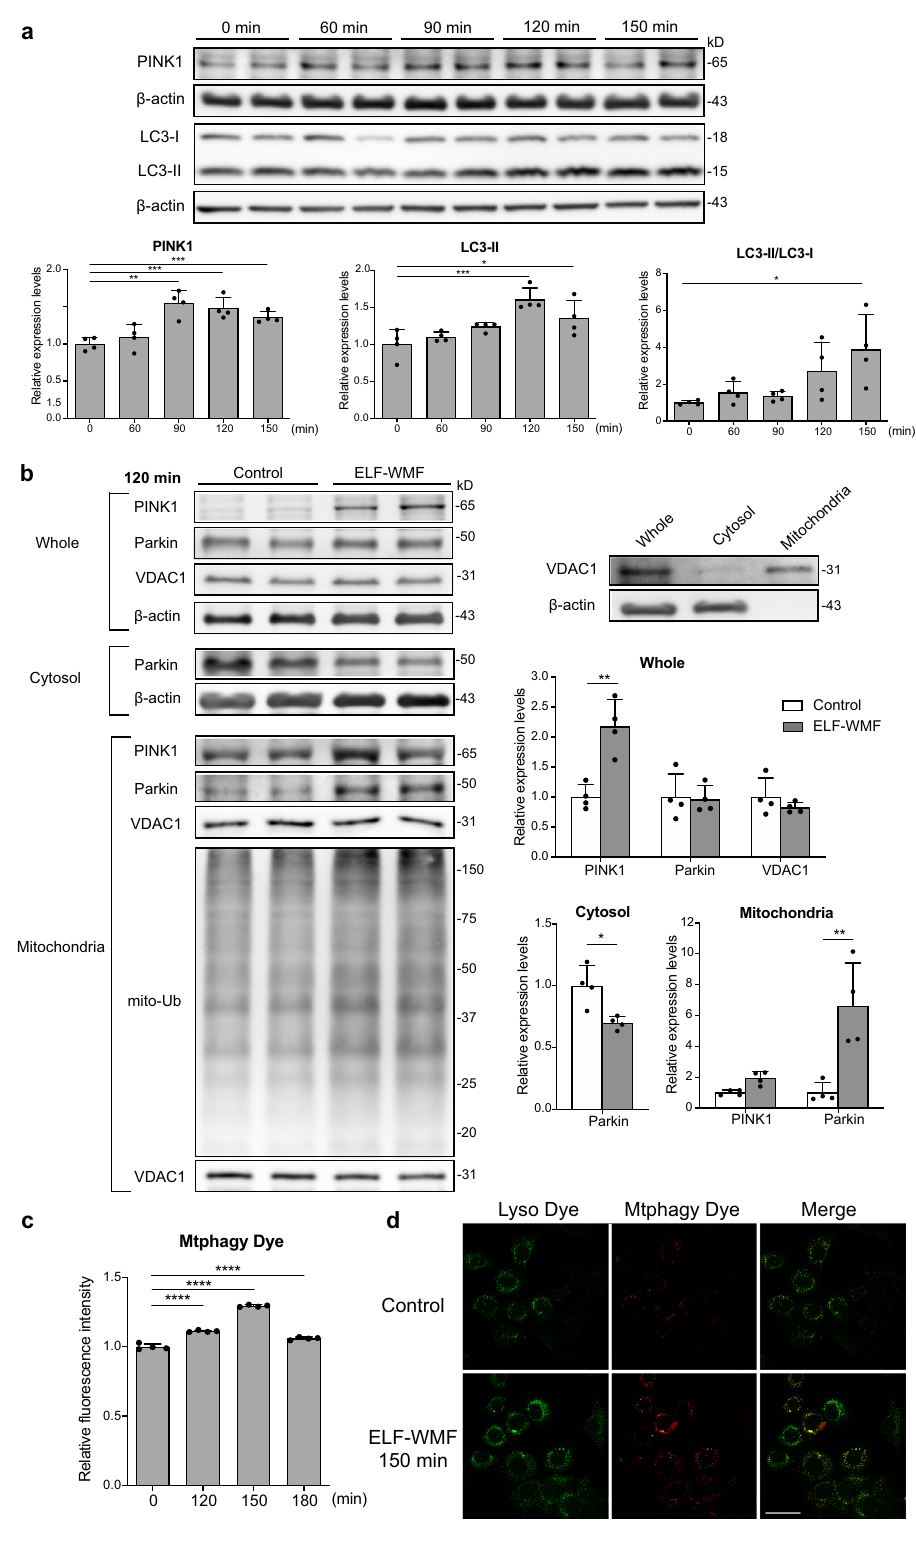
pro fi les (Supplementary Fig. 2c) markedly attenuated the effects of ELF-WMF on the mitochondrial mass. As the conditions of Opti-ELF-WMF exerted the maximum effects on the hysteresis of electronic resistance of modi fi ed Ringer ’ s solution in vitro and on the reduction of mitochondrial mass in vivo, the identity of the molecular target of Opti-ELF-WMF on ETC complex II subunits may share a feature similar to that of modi fi ed Ringer ’ s